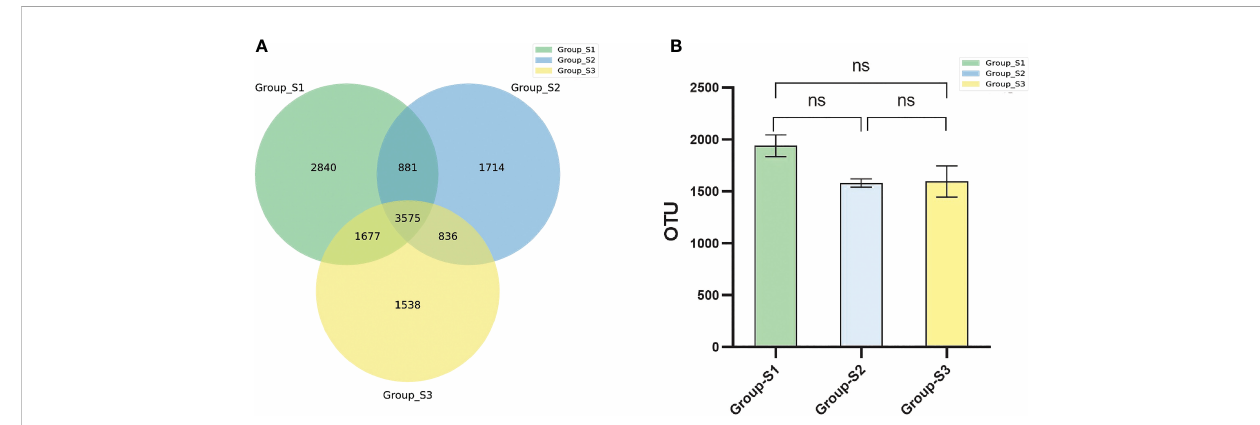
FIGURE 2 Comparison of bacterial OTU numbers in different groups. (A) Venn diagram of the OTUs in the respiratory tract specimens of the three groups. (B) Boxplots of the OTU numbers in respiratory tract specimens among the three BMI groups. (ANOVA, ns: P <0.05, there were no statistical differences between different groups.).